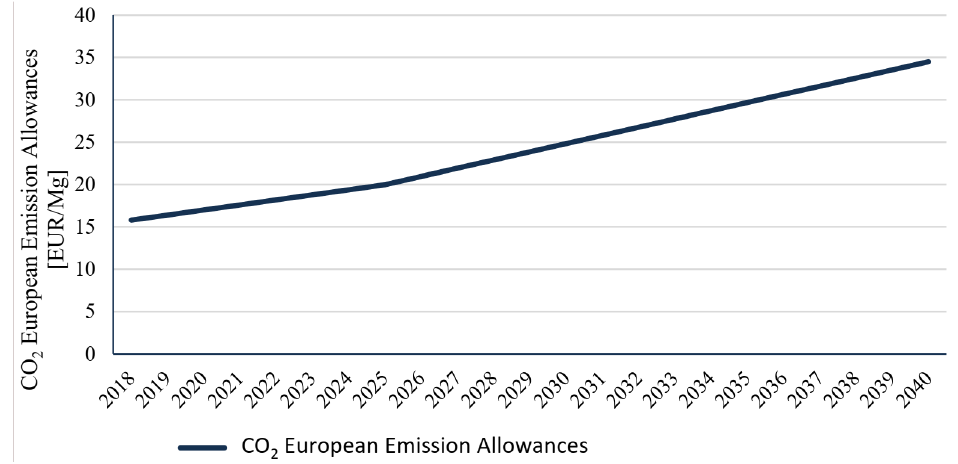
Figure 9. CO 2 European Emission Allowances in 2018–2040 (based on [35,39]).